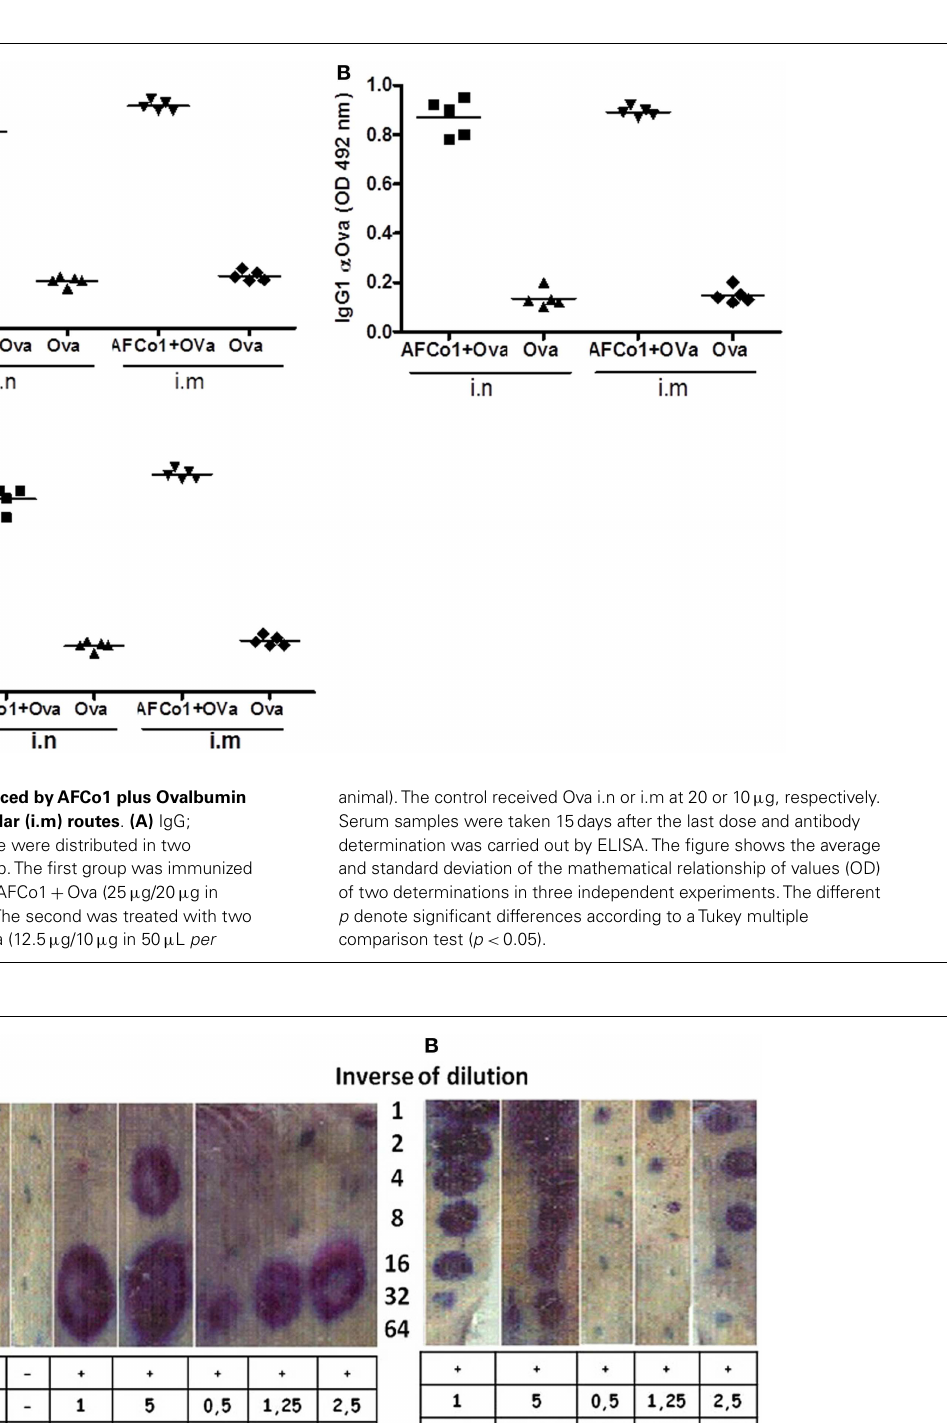
FIGURE 5 | Passive cutaneous anaphylaxis . Male rats were inoculated subcutaneously with 100 µ L of sera from mice immunized intramuscularly with two doses 15days apart of Dermatophagoides siboney (Ds) allergen adsorbed onto aluminum hydroxide (Alum) at 1 or 5 µ g per dose, or adjuvanted with AFPL1 (PL at 12 µ g) in Alum at Ds concentrations of